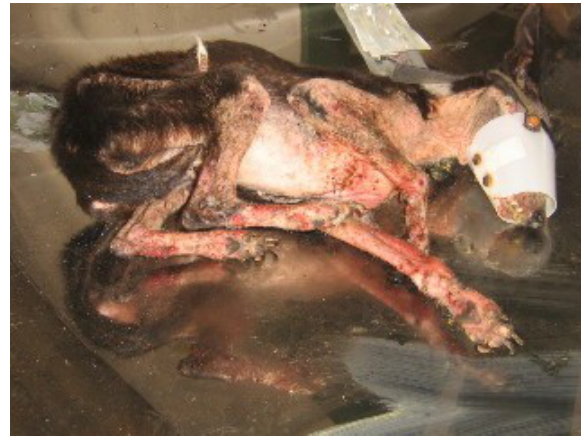
Figure 1. Dog showing weight loss and